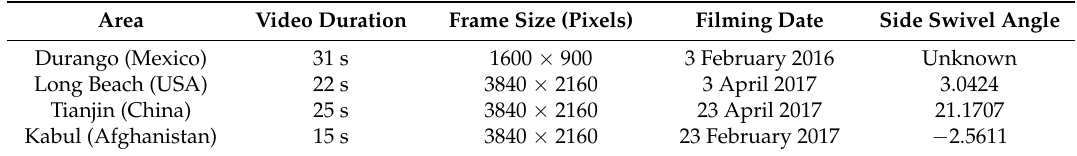
Table 1. Description on experimental videos (from Chang Guang Satellite Technology Co.